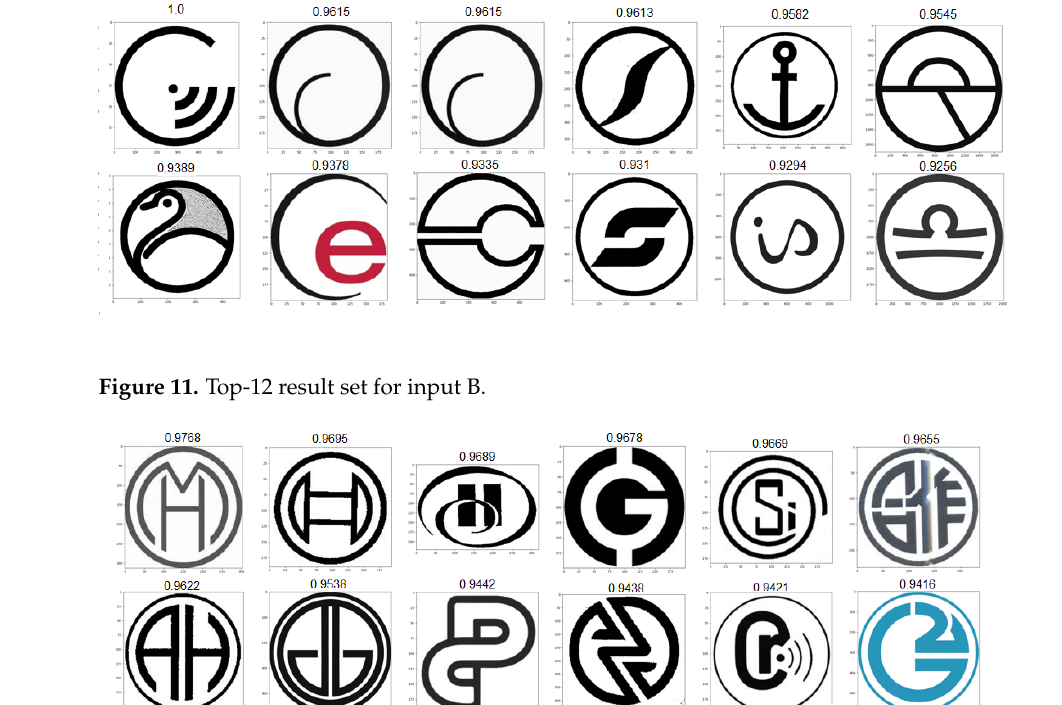
Figure 12. Top-12 result set for input C.